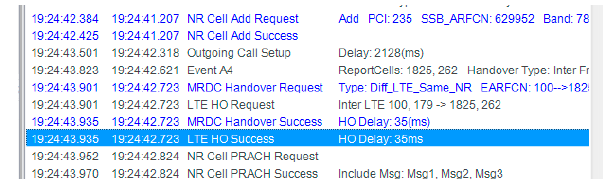
Figure 13. Sharer 5G access inter-frequency handover.